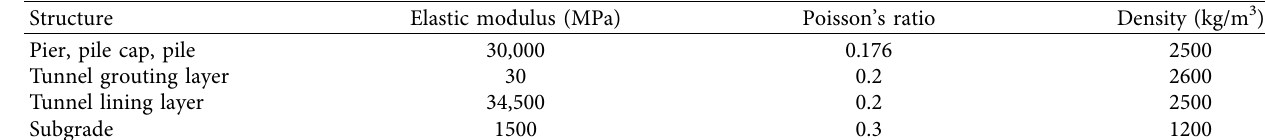
Table 5: Calculation parameters of the structural